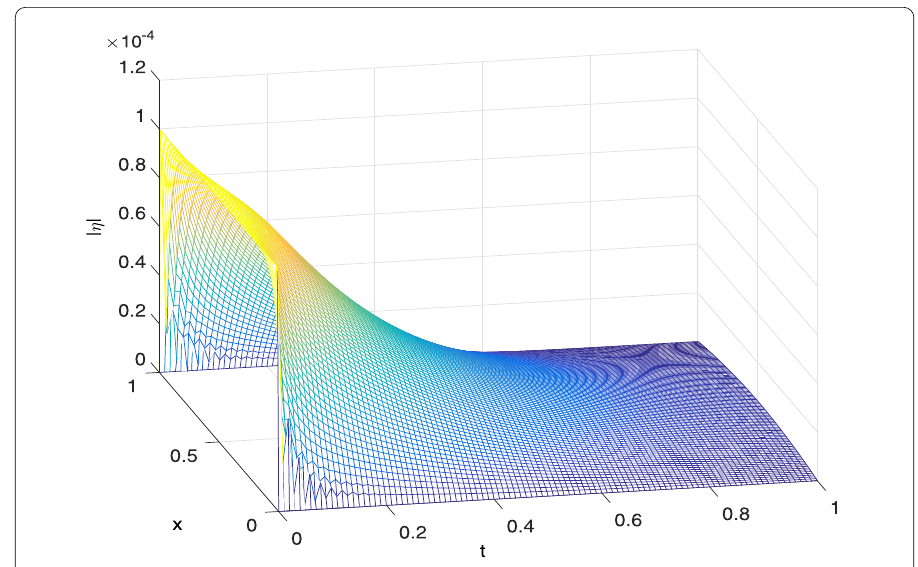
Figure 2 Numerical solutions for the perturbation equations of Example 1 with h = τ = 0.01, α = 1.5, λ = 1